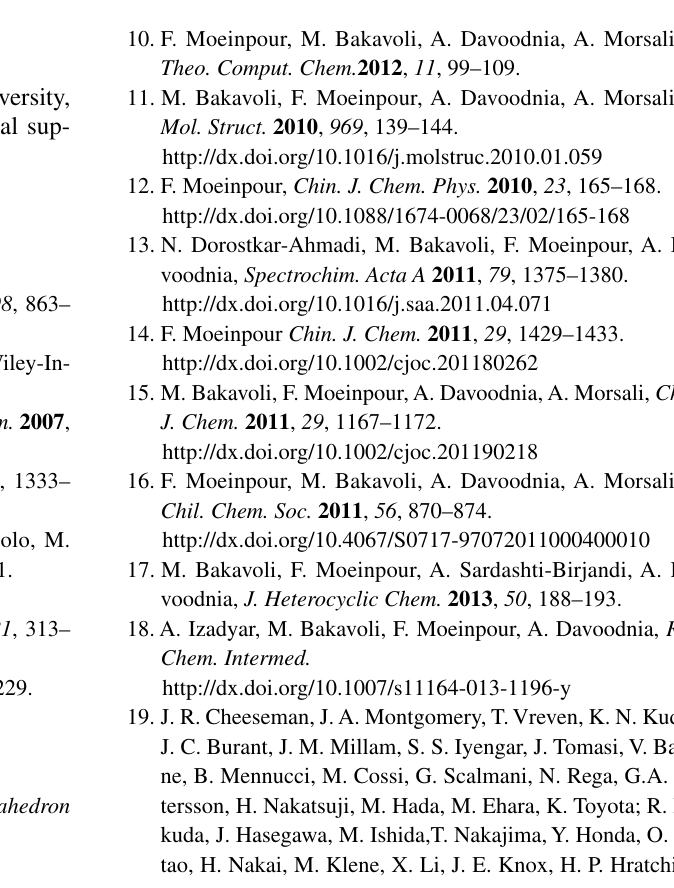
and local electrophilicities, ω k